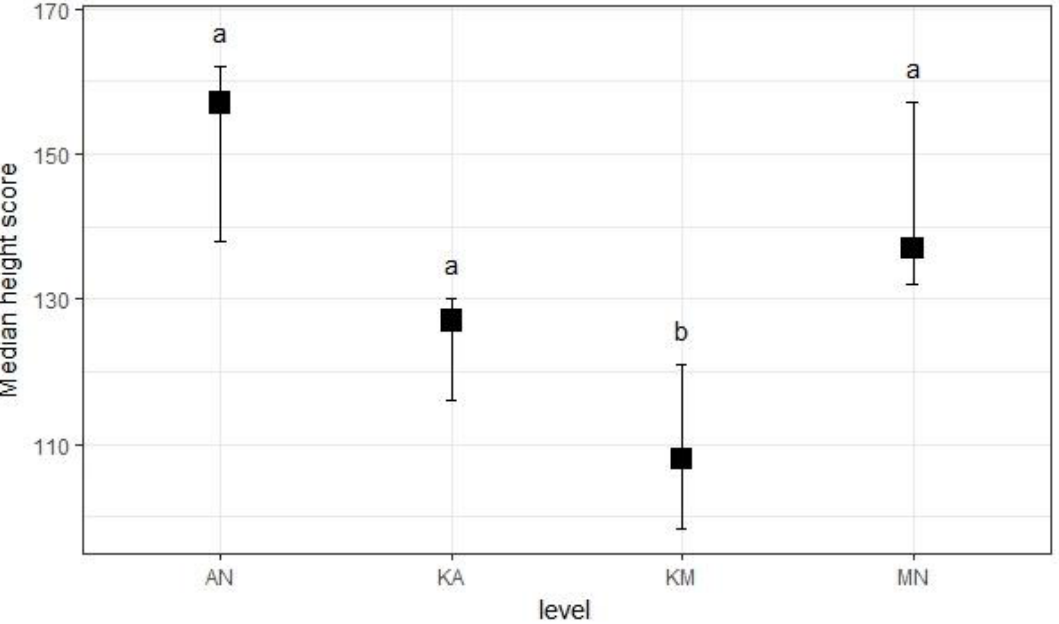
Figure 11. Results of Wilcoxon rank sum test on tree height under two different treatments, i.e.,